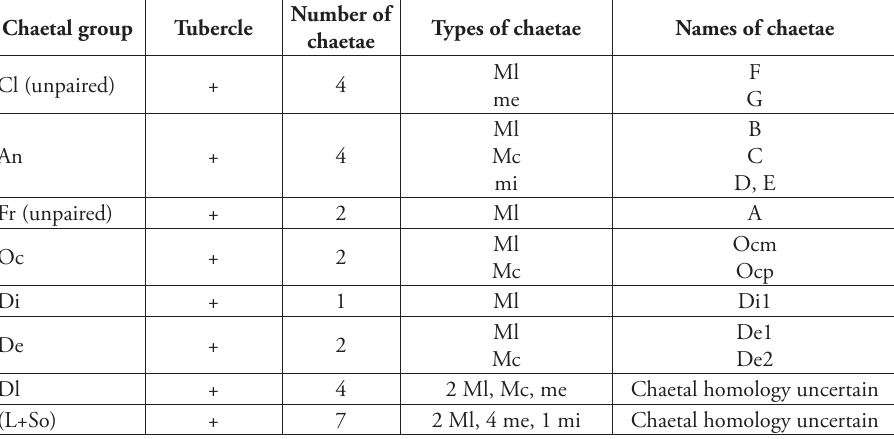
Table 2a. Chaetotaxy of Lobellina pomorskii sp. n.: cephalic chaetotaxy of dorsal side. Number of Chaetal group Tubercle chaetae